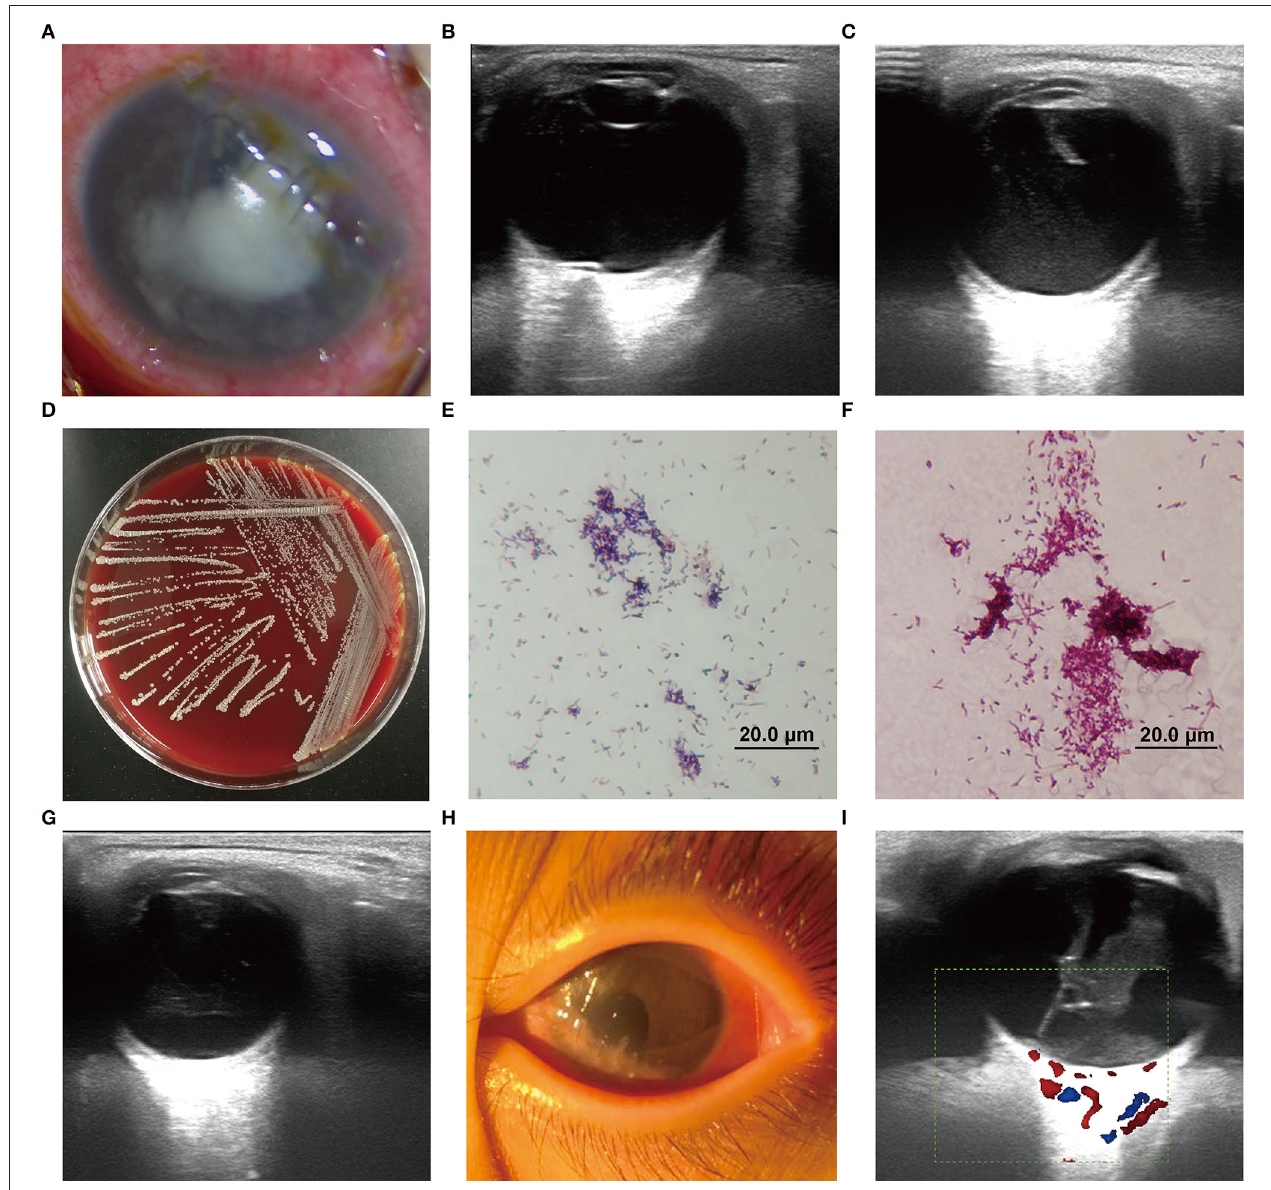
FIGURE 2 | (A) Left eye with a massive white exudate gathered in the pupil area. (B,C,G,H) B-mode ultrasound of the left eye in different treatment stages. (D) The culture colonies of strain BCHNH01 T on blood agar plate after 48h culture. (E,F) The gram-staining and weak acid-fast staining (modified the Kinyoun’s method) of strain BCHNH01 T . (I) Vitreoretinal traction and suspicious retinal detachment were observed in the left